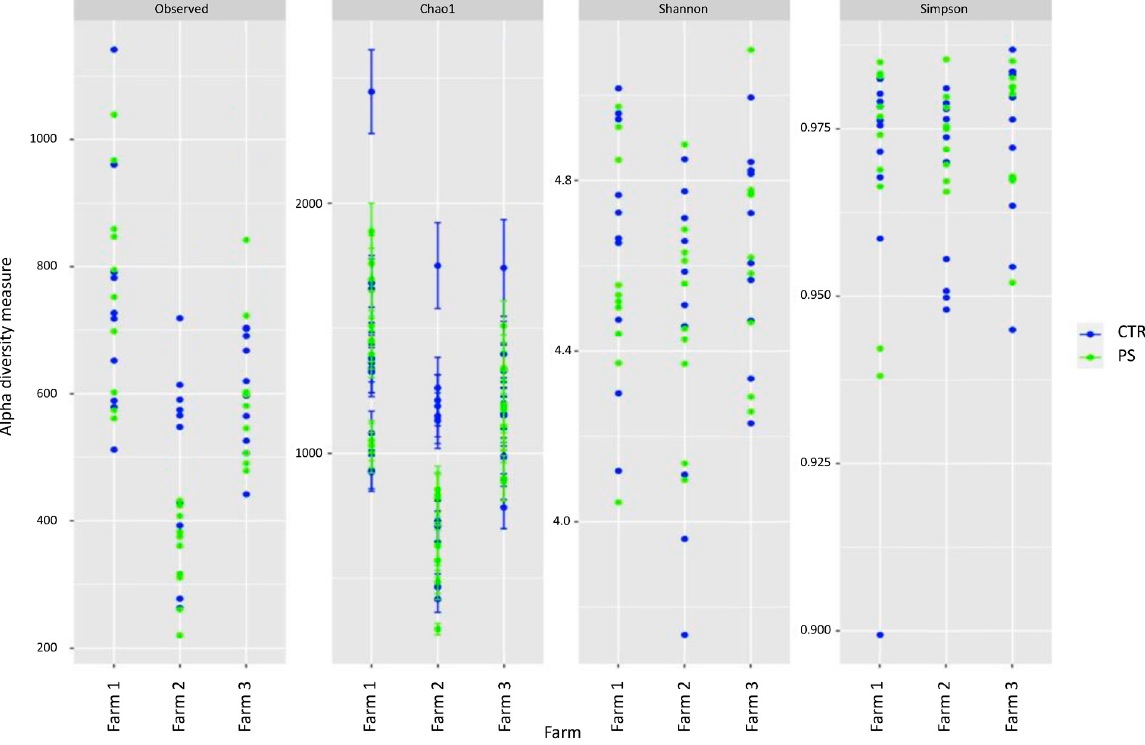
Figure 5. Alpha diversity measures for all caecal content samples divided by farm and color-coded based on treatment (green for synbiotic-treated chickens, blue for control ones).